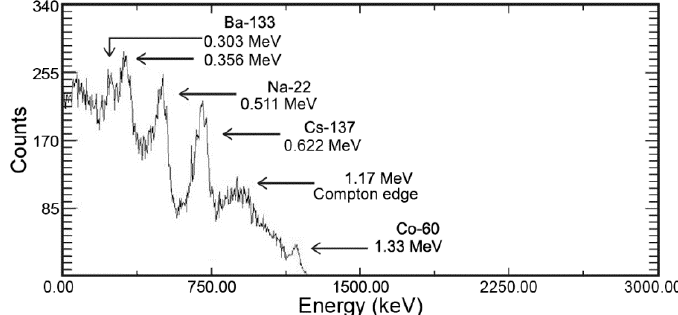
Figure 6. Energy spectra emitted from 133 Ba (0.303 MeV and 356 MeV), 22 Na (0.511 MeV), 137 Cs (0.662 MeV), and 60 Co (1.33 MeV).